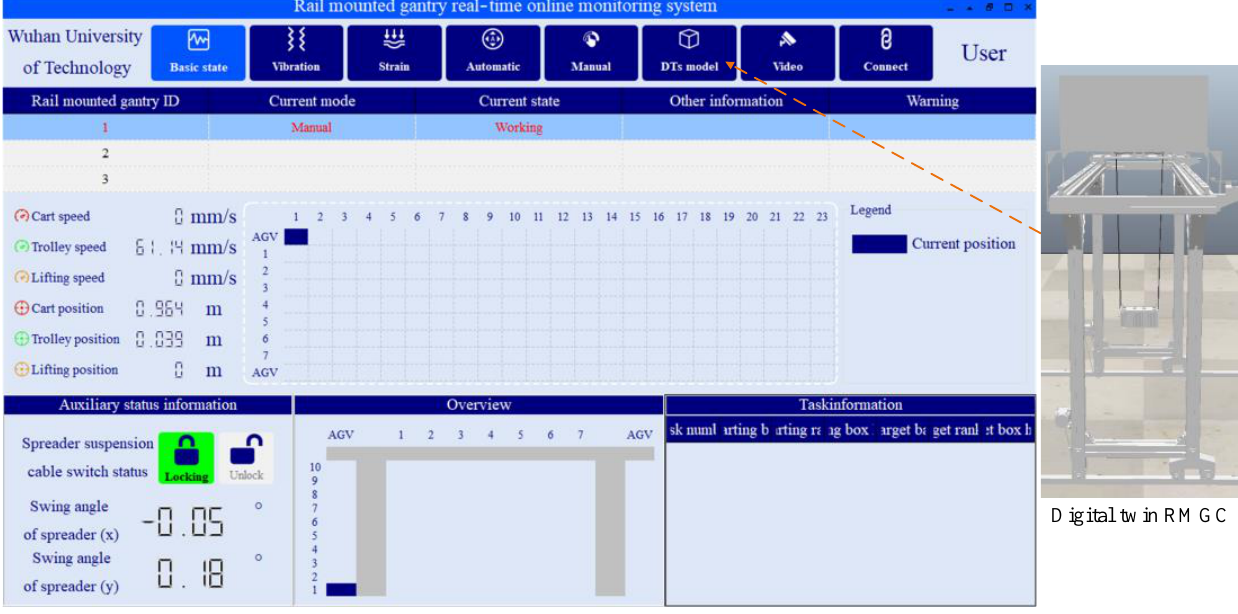
Figure 13. Monitoring system interface.